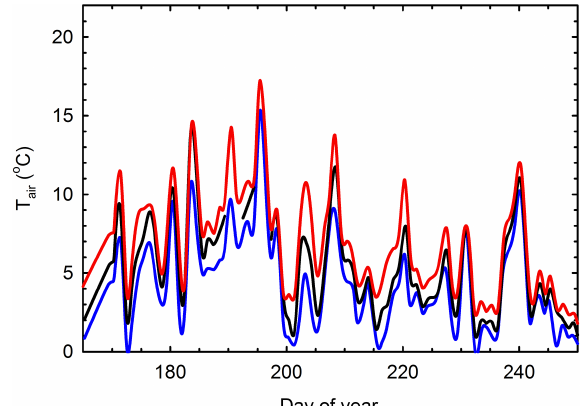
Figure 5. Mean daily air temperature measured at canopy height in the ambient plot (blue line), the control chamber, with fixed venting (black line), and the ZPW chamber, with modulated venting (red line). In order to evaluate chamber effects the control chamber was closed on DOY 190, 191, 195 and 196; data for these days are not shown.